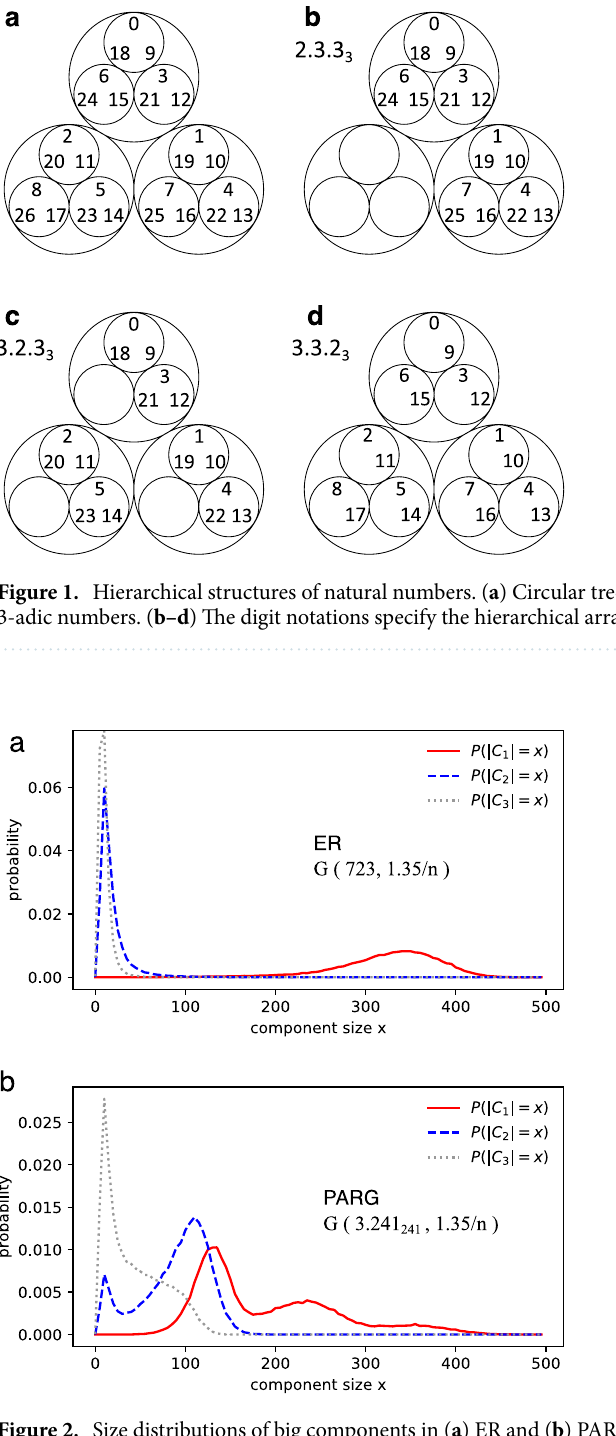
Figure 2. Size distributions of big components in ( a ) ER and ( b ) PARG. The probabilities are drawn from 60,000 of random realizations (see “Methods” section). Both models have the same degree distribution, and they contain the same number of edges (487 edges), as PARG’s connecting probability (1) is normalized by p ij = n ( n − 1 ) p ∗ / 2 ij (cid:31)